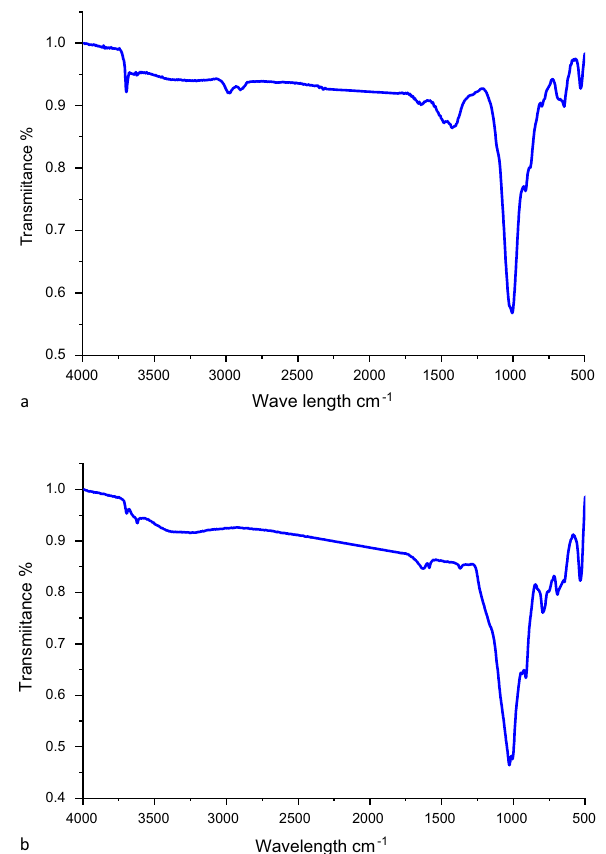
Figure 4. FTIR Images of nano bentonite ( a ) and ( b ) MgO impregnated into clay after MG